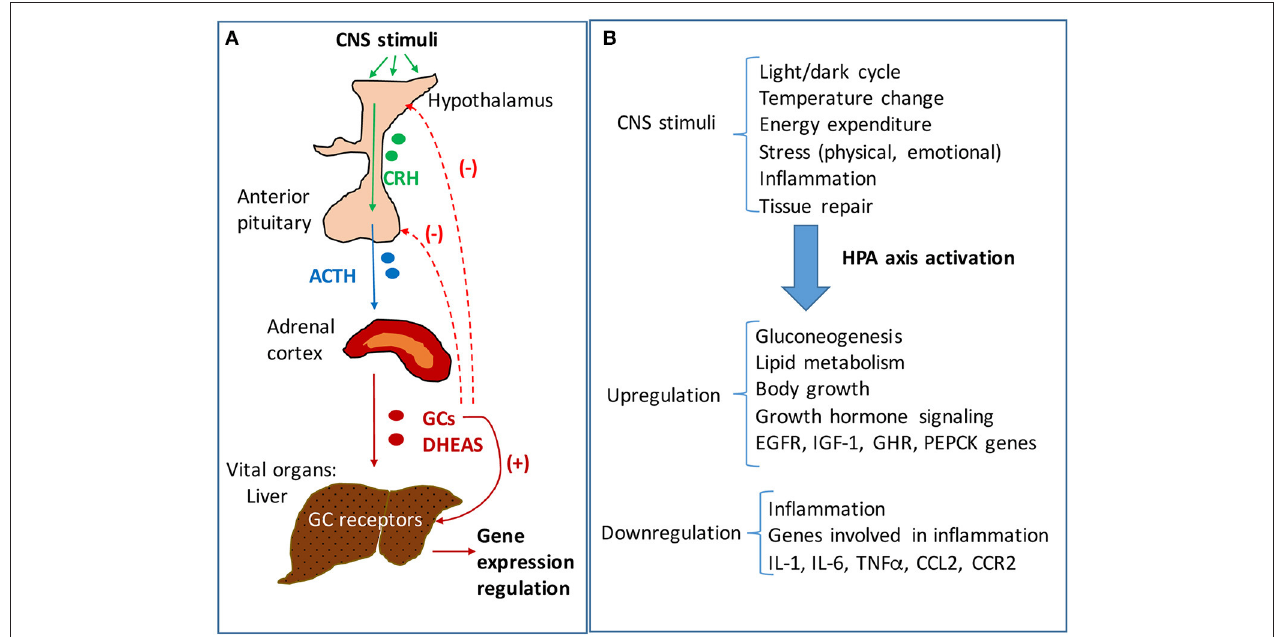
FIGURE 1 | The hypothalamic-pituitary-adrenal (HPA) axis signaling and regulation of hepatic functions. (A) Neuroendocrine signaling pathway of HPA axis. Stimuli of central nervous system (CNS) result in activation of HPA axis signaling, starting with the hypothalamus’ increased secretion of corticotropic releasing hormone (CRH). CRH activates the anterior pituitary gland to secrete adrenocorticotropic hormone (ACTH) which in turn stimulates the adrenal glands to produce glucocorticoids (GC) and androgens (DHEAS). The adrenal steroids reach vital organs such as the liver where they bind specific receptors with transcriptional functions. GC bind to glucocorticoid receptors (GR) which are highly expressed in liver, and modulate the expression of many genes involved in energy production and homeostasis, growth and inflammation. The liver is mainly regulated by HPA axis, but there are interactions of HPA axis with other hypothalamus-dependent signaling pathways. While GC stimulate downstream pathways, they also trigger a negative feedback loop, inhibiting CRH and ACTH production in hypothalamus and pituitary, respectively. (B) HPA axis regulation of liver functions in response to CNS stimuli. The liver controls the rate of energy fuel distribution to the body depending on HPA axis signaling. In periods of rest and relaxation the activity of HPA axis is low so that the liver stores glucose into glycogen and has a reduced rate of lipolysis directing the lipids for storage in the adipose. In contrast, in times of intense activities of the body when large amounts of energy are needed, the HPA axis is stimulated and results in signaling the liver to produce glucose and put it in blood circulation, to oxidize lipids and to enhance the rate of ATP production in the whole